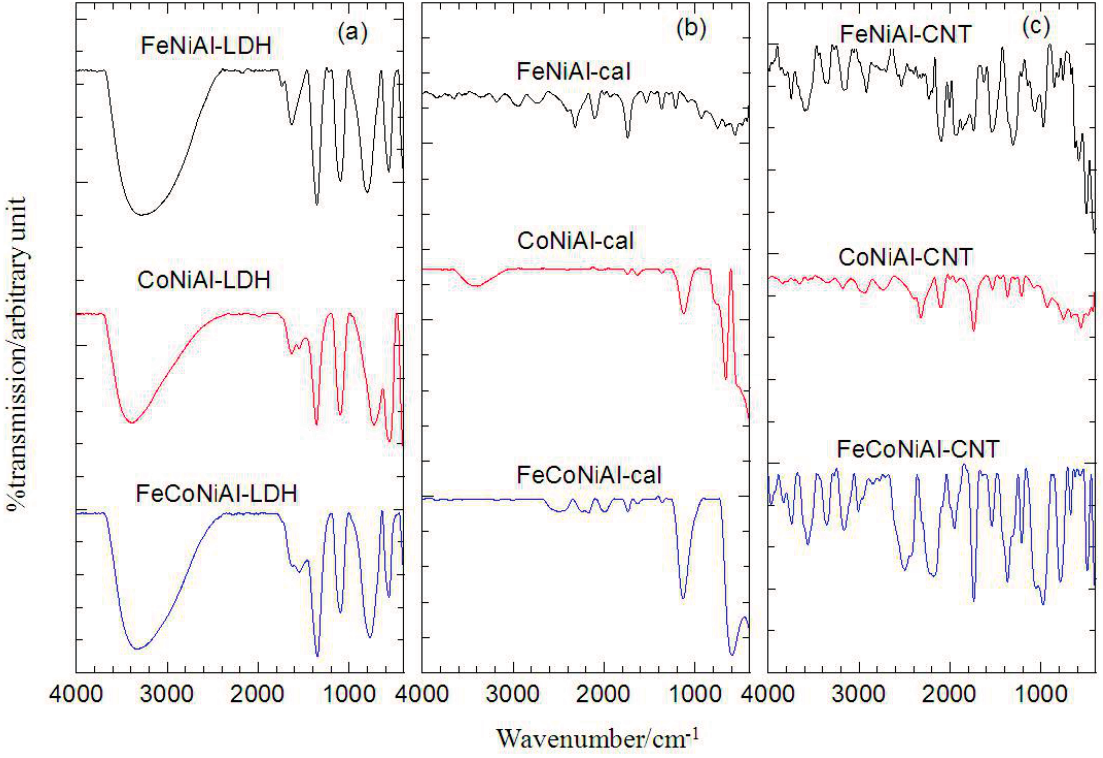
Figure 2. FTIR of LDH ( a ) calcined LDH ( b ) and CNT over calcined LDH ( c